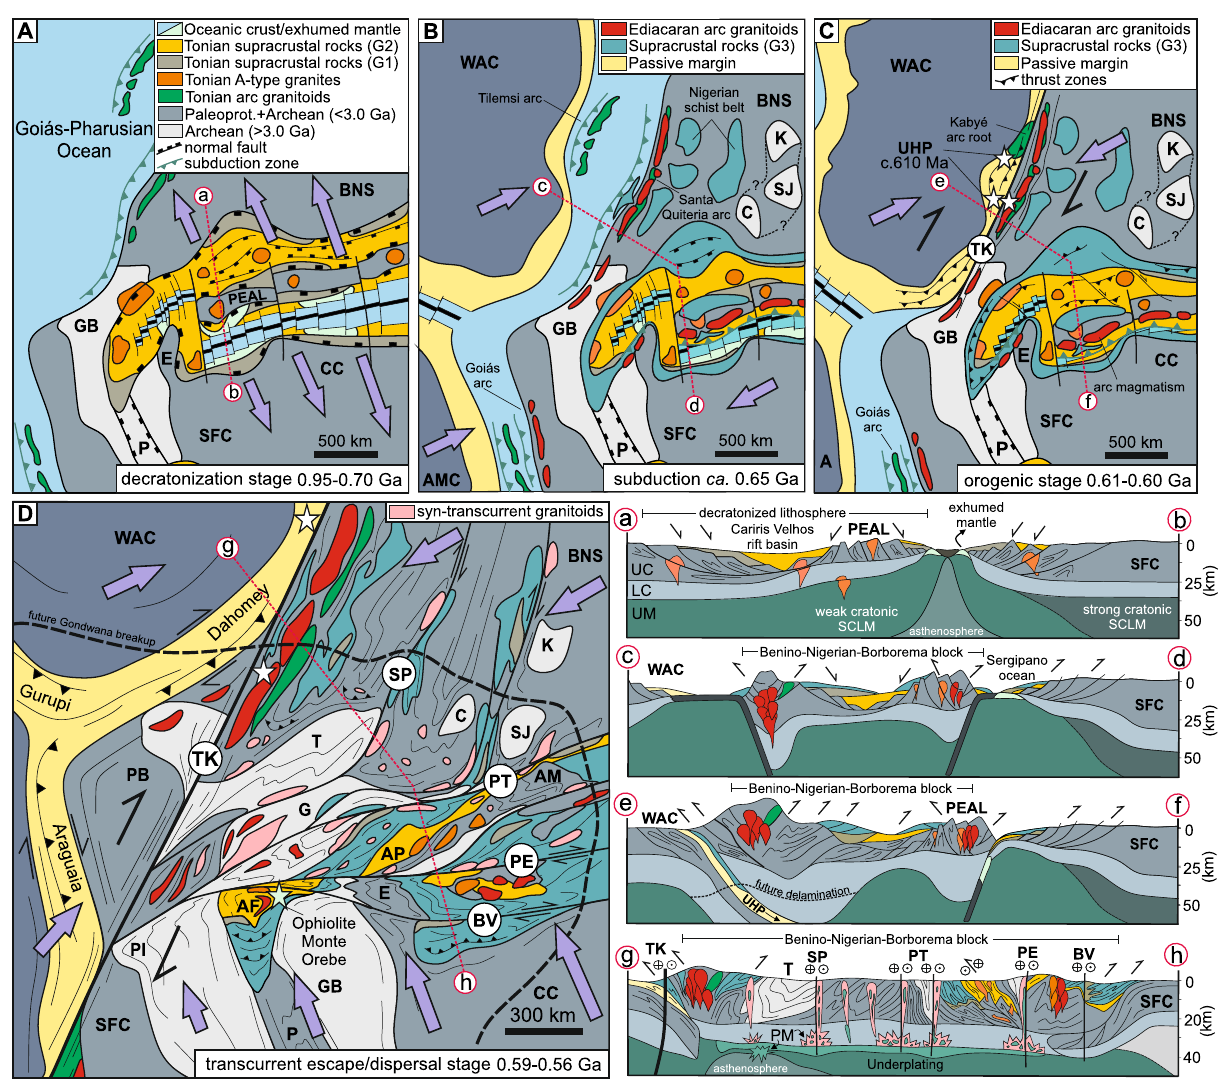
Figure 6. Neoproterozoic decratonization, transcurrent tectonics and terrane dispersion in NE Brazil. ( A ) Overall extension of the São Francisco Craton/Benino-Nigerian Shield ( SFC and BNS ), following intrusion of intraplate Cariris Velhos granitoids (1.0–0.92 Ga in orange) and leading to development of Tonian rift basins in restricted oceanic realms at 0.85–0.70 Ga ( c.f. Sergipano Ocean recorded by the ca. 0.82 Ga Monte Orebe ophiolite 28 (blue star in C) and aulacogens such as the 0.9–0.5 Ga Paramirim ( P ). Inception of peripherical intraoceanic and transitional arcs in the west along the Goiás-Pharusian Ocean. The Gavião Block ( GB ) is the old Archean cratonic core of the conjoined São Francisco Craton ( SFC ), Congo Craton ( CC ) and the Benino-Nigerian Shield ( BNS ). The Pernambuco-Alagoas terrane ( PEAL ) represents a continental ribbon of SFC rocks within the rift, that was extensively intruded by Neoproterozoic granitoids. Note the Entremontes ( E ) promontory on the paleomargin of the SFC. ( B ) Subduction stage marked by intrusion of continental arc related granitoids such as the Santa Quitéria and Major Isidoro/Betania arcs in the western and southern Borborema Province, respectively. Also shown are the Archean domains of Kaduna ( K ), Campo Grande ( C ) and São José do Campestre ( SJ ) and the Nigerian schist belts of the Benino-Nigerian Shield. ( C ) Overall shortening of the interior basins (Tonian rift + Brasiliano/Pan-African Ediacaran orogenic-related basins) as a response to the oblique continental collision along the West Gondwana Orogen ( WGO ) marked by ultra-high-pressure (UHP) metamorphism, and nucleation of the dextral Transbrasiliano- Kandi shear zone ( TK ) 17,19 as a result of continental collision in the west. This stage is also marked by continental arc magmatism (0.63-0.60 Ga) in the Southern Borborema Orogen 16 and shearing along the inactive Santa Quitéria arc 17 . ( D ) Zoom on NE Brazil and NW Africa illustrating final shortening, inversion of rift basins and development of the Borborema transcurrent shear zone system as a consequence of the double cratonic indentation associated with continued convergence of the West African Craton against the greater São Francisco-Saharan paleocontinent in the west and a counterclockwise rotation of the São Francisco Craton in the south. Transpression deformed and dispersed terranes sourced from the SFC within the Borborema Province. Transcurrent shear zones are associated with crustal heating and magmatism associated with delamination of the lithospheric mantle and asthenospheric upwelling 80,81 that facilitated lateral crustal flow. Position of the cross-sections (on the right-hand-side of D) are indicated by pink dashed lines in A to D. Arrows and their size indicate direction and relative magnitude of the stresses, respectively. Shear zones: TK Transbrasiliano-Kandi, PE Pernambuco, PT Patos, SP Senador Pompeu, BV Boa Vista. Disrupted Tonian and cratonic domains: AF Afeição, AP Alto Pajeú, AM Alto Moxotó, T Tróia, G Granjeiro, PI Cristalândia do Piauí. PM in cross section (g) to (h) is partial